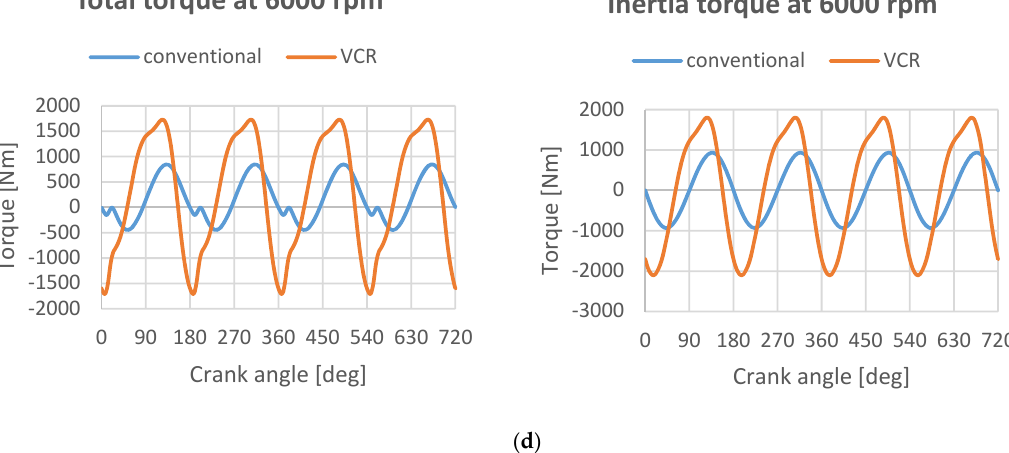
Figure 11. ( a ). Con ‐ rod big end force [N], ( b ). Torque engine evolution on a complete cycle for a total torque of 1000 rpm, ( c ). Torque engine evolution on a complete cycle for a total torque of 3500 rpm, ( d ). Torque engine evolution on a complete cycle for a total torque of 6000 rpm.